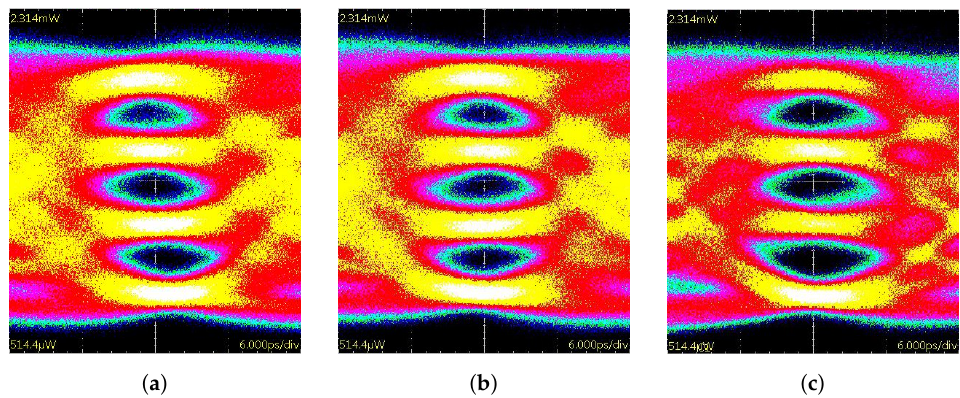
Figure 10. 80 Gbit/s eye diagrams using different pre-emphasis: 6 TX taps of, ( a ) linear FFE, ( b ) adaptive FFE with four sets of coefficients and ( c ) adaptive FFE with 12 sets of